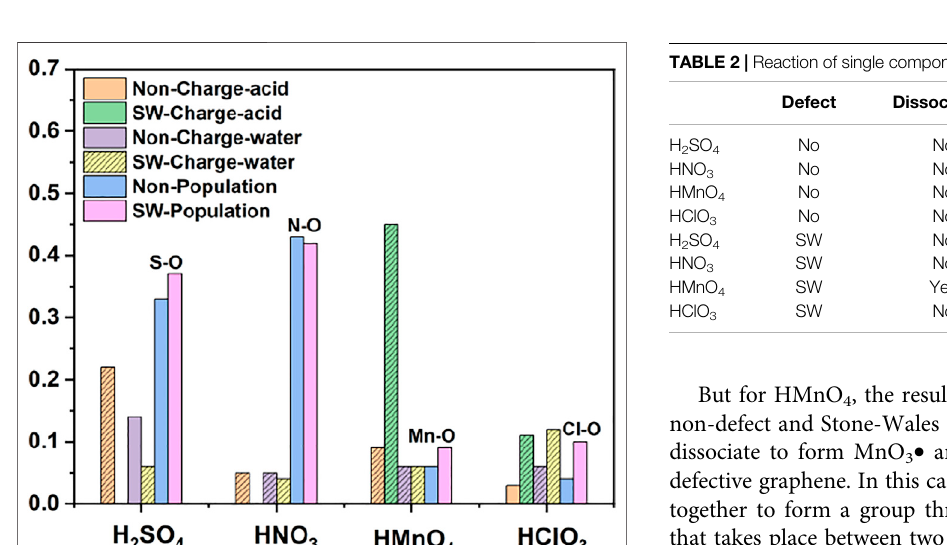
FIGURE 5 | DOS of single-component acid molecules reacting with the Stone-Wales defect graphene in aqueous condition. (A) , (B) , (C) , and (D) are the DOS of H 2 SO 4 , HNO 3 , HClO 3 and HMnO 4 , respectively. In each diagram, the top represents the TDOS, and the bottom represents the LDOS of OH (cid:129) at the bottom of (D) . the LDOS of MnO 3